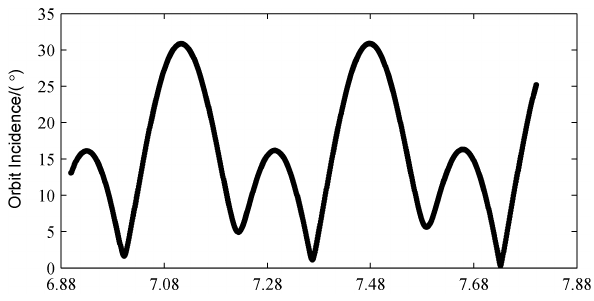
Figure 2. Variations of the orbit incidence